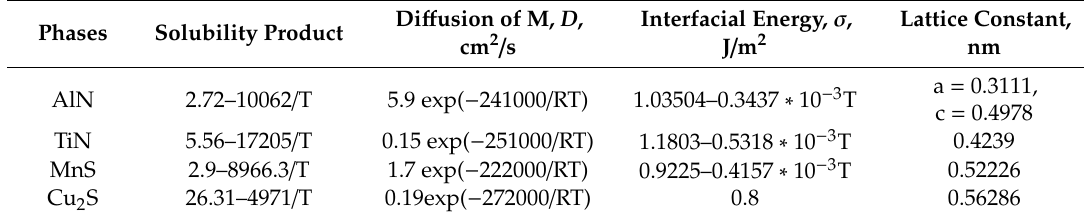
Table 3. Parameter values for calculation